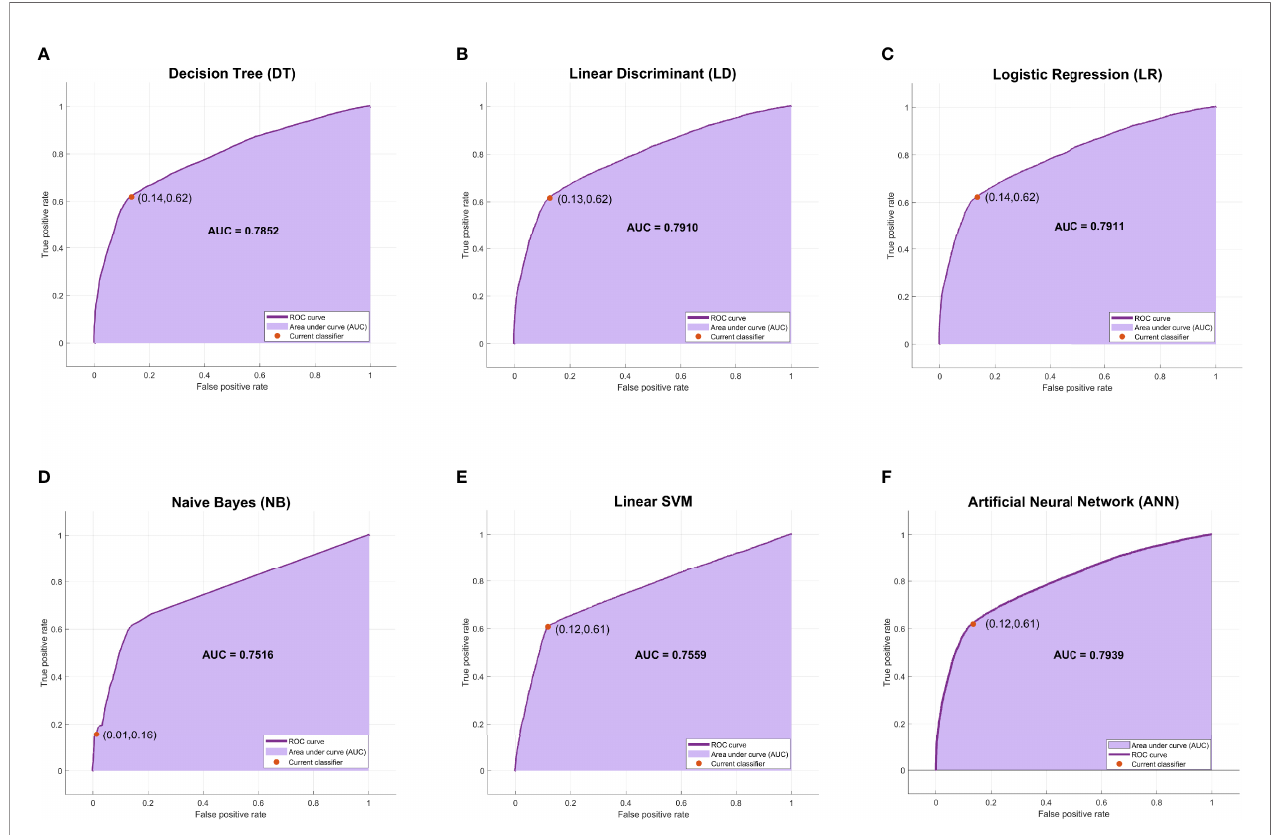
FIGURE 3 | The ROC curves and AUC scores of six machine learning models. (A) The ROC curve and AUC score of the DT model: the deep purple curve refers to the ROC curve, the area under the curve is covered by light purple color, the orange dot represents the threshold that corresponds to the optimal operating point, and the AUC score is clearly marked. (B – F) The ROC curve and AUC score of LD, LR, NB, Linear SVM, and ANN, respectively. ROC, receiver operating characteristic; AUC, area under the receiver operating characteristic curve; DT, decision tree; LD, linear discriminant; LR, logistic regression; NB, naive Bayes; ANN, arti fi cial neural